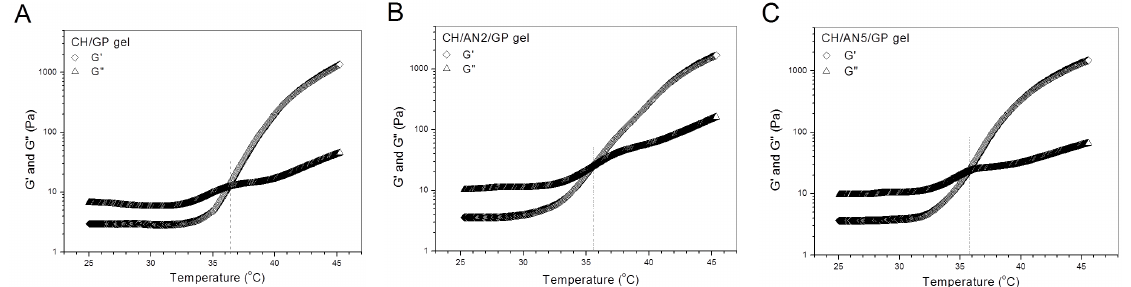
Figure 3. Typical temperature-dependence transitions of G ′ and G ′′ for three kinds of gels without BMP-2 load (CH in these gels: 2.0 w / v %; GP content in these gels: 5.0 w / v %; AN2 NPs: 1.5 w / v %; and AN5 NPs: 1.5 w / v %; see Table 1 for parameters of AN2 and AN5 NPs).